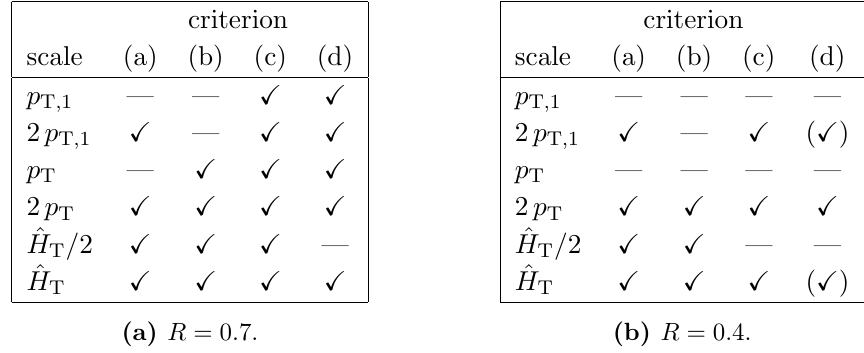
Table 2 . Summary of scales vs. criteria for (a) R = 0 : 7 and (b) R = 0 : 4 cone sizes. bin(s) below (cid:24) 150 GeV. For the larger cone size of R = 0 : 7, on the other hand, the issue of negative cross sections at NLO is largely alleviated, where only the choice (cid:22) = ^ H exhibits this unphysical